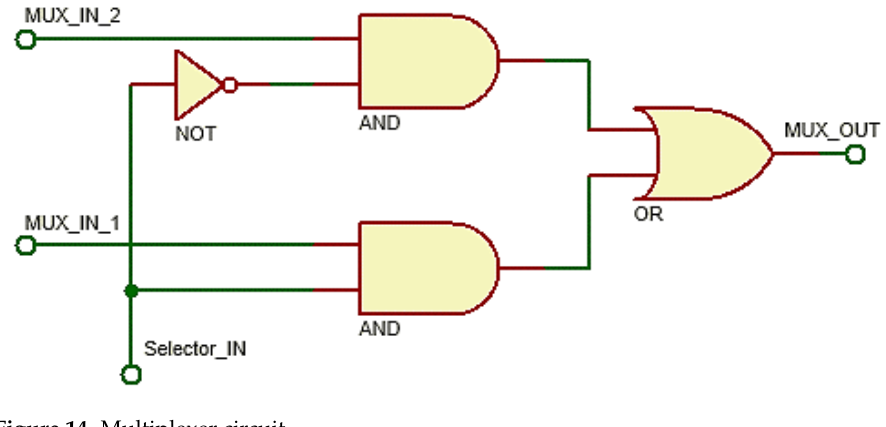
Figure 14. Multiplexer circuit.